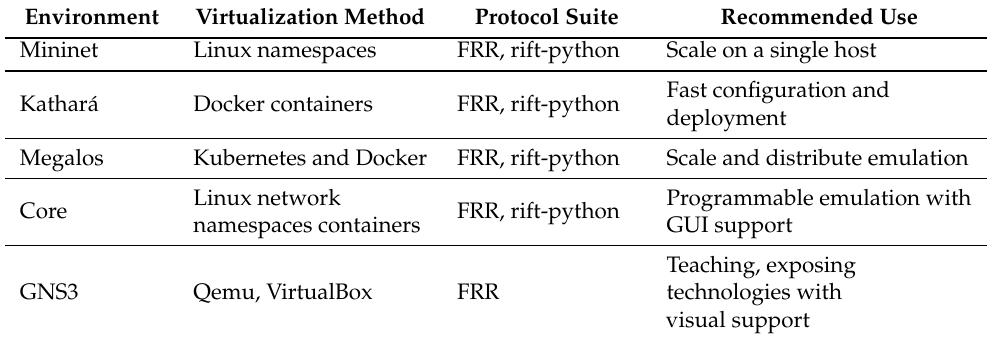
Table 3. Validation test over all the